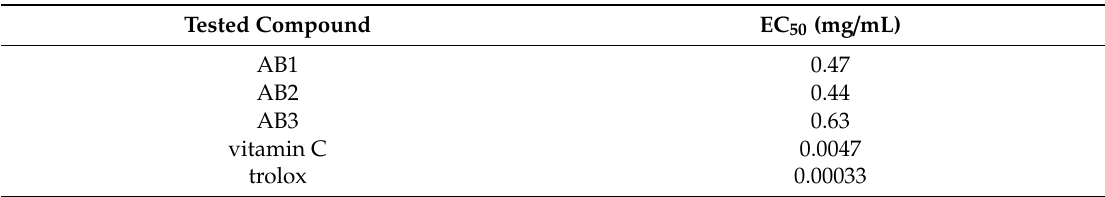
Table 3. Antioxidative properties of the phenazine dyes tested by chemiluminescence assay and expressed as EC 50 values in comparison to the vitamin C and trolox as positive